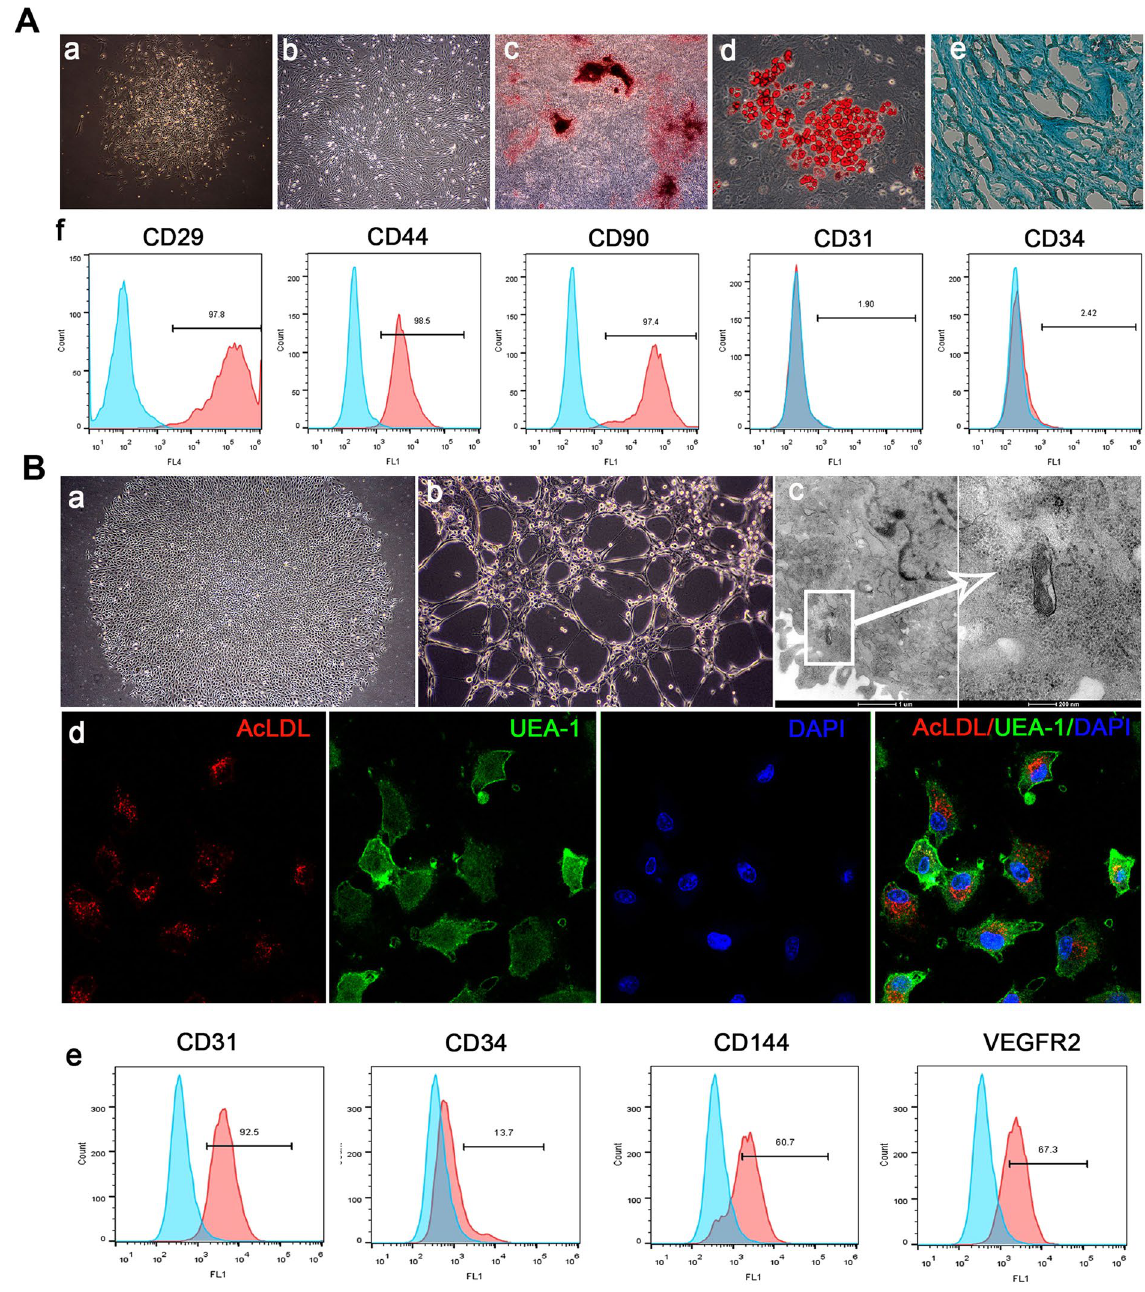
Figure 1. Characterization of BMSCs and EPCs. ( A ) Characterization of BMSCs a: Primary culture of BMSCs (Original magnification x100) b: Subculture of BMSCs (P3, Original magnification x100) c: Mineral node stained with Alizarin Red S (Original magnification x40) d: Fat droplets stained with Oil Red O (Original magnification x200). e: Proteoglycans were stained with Alcian blue (Original magnification x200). f: Flow cytometry analysis of BMSC surface markers. ( B ) Characterization of EPCs a: Primary culture of EPCs (Original magnification x40) b: Lumen formation (Original magnification x100). c: Weibel-Palade body. d: Uptake of DiI-Ac-LDL and FITC-UEA-1. e: Flow cytometry analysis of EPC surface